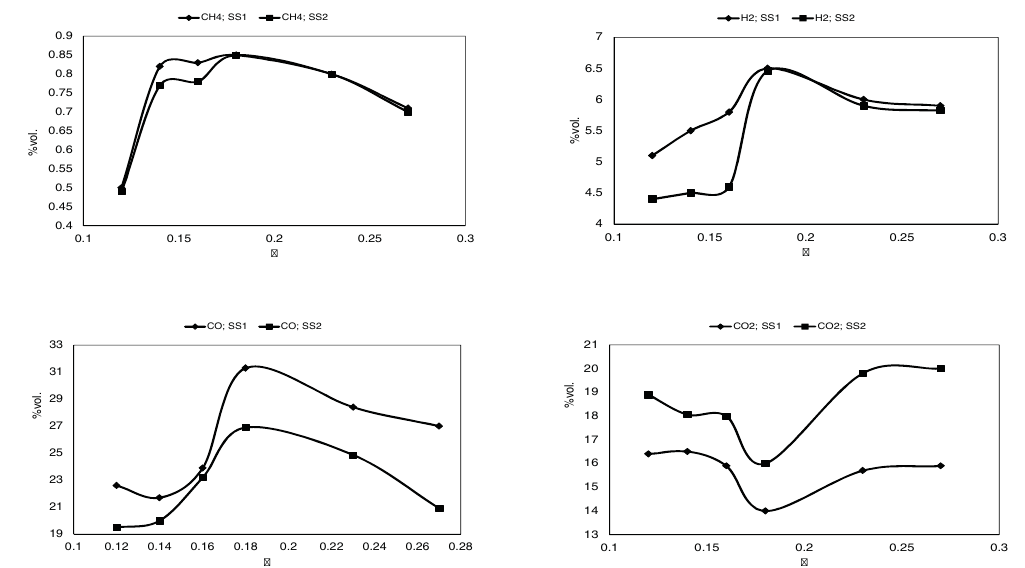
Fig. 2. Evolution of the main components in sewage sludge gasi fi cation gas as a function of the air ratio.